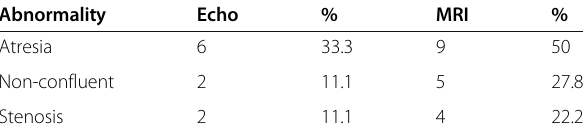
Table 1 Number of patients according to type of pulmonary artery abnormality by echocardiography and MRI Abnormality